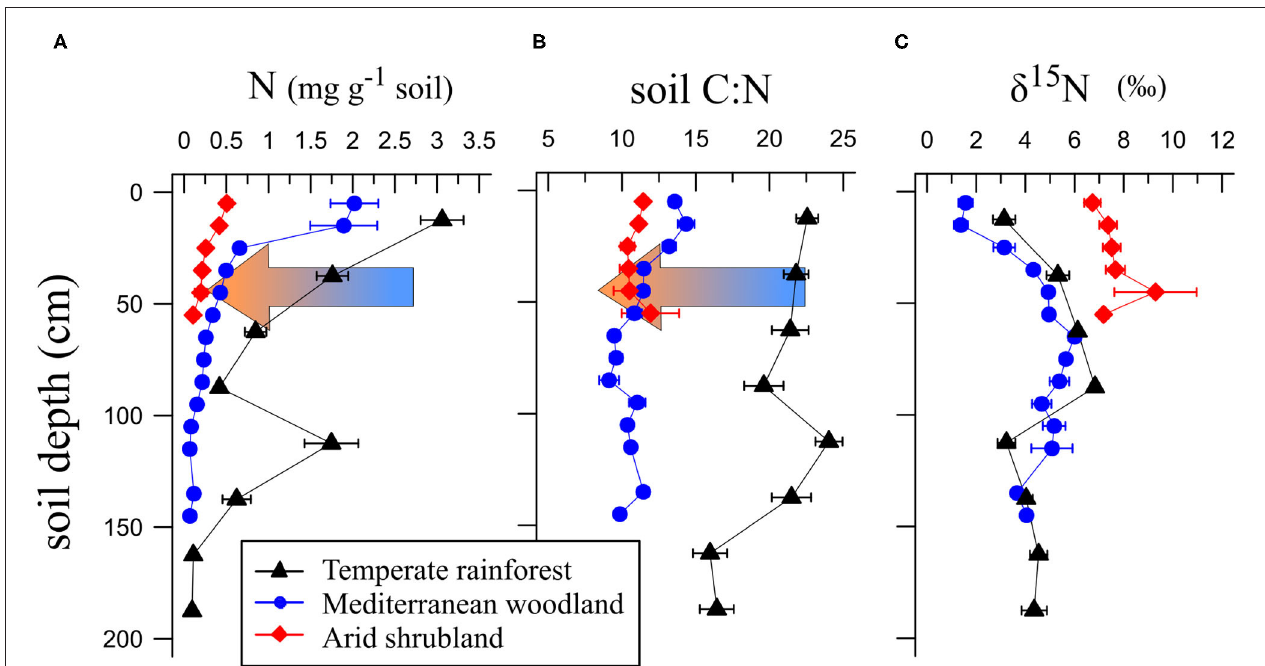
FIGURE 1 | Total nitrogen content (A) , soil C:N ratio (B) , and δ 15 N values (C) in soil profiles in the temperate rainforest, Mediterranean woodland, and arid shrubland. Data are presented as means ( n = 8) with standard errors. Arrows indicate direction of increasing aridity. Nitrogen contents and C:N ratios decrease markedly with increasing aridity. δ 15 N values were lowest in soil under Mediterranean